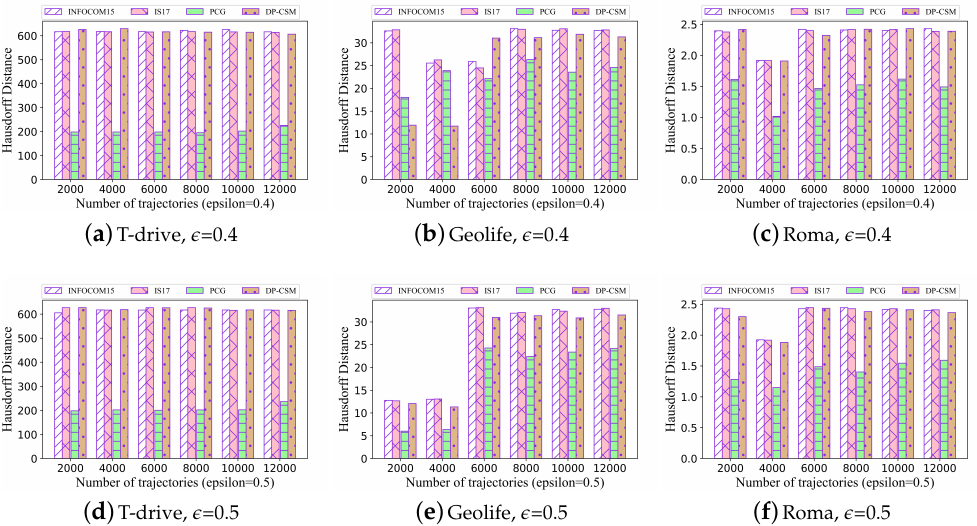
Figure 5. Hausdorff distance comparison of the four models under different settings. In particular, we fix k = 80 and vary the privacy budget (cid:101) and the size of trajectory datasets. For the privacy budget, we choose two kinds of values, i.e., (cid:101) = 0.4 and (cid:101) = 0.5, respectively. Under each privacy budget, we vary the sizes of trajectory datasets.